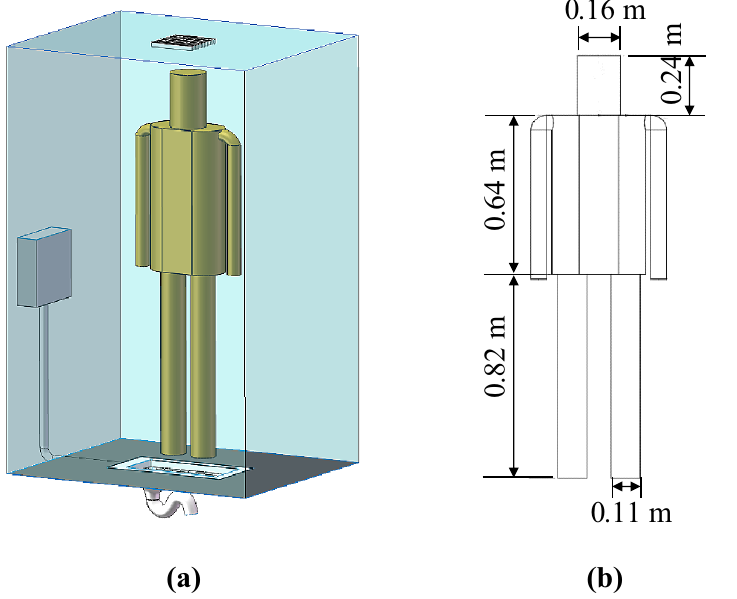
Figure 11. Standing thermal manikin to simulate a lavatory user after toilet flushing: ( a ) picture of the manikin, ( b ) dimensions of the